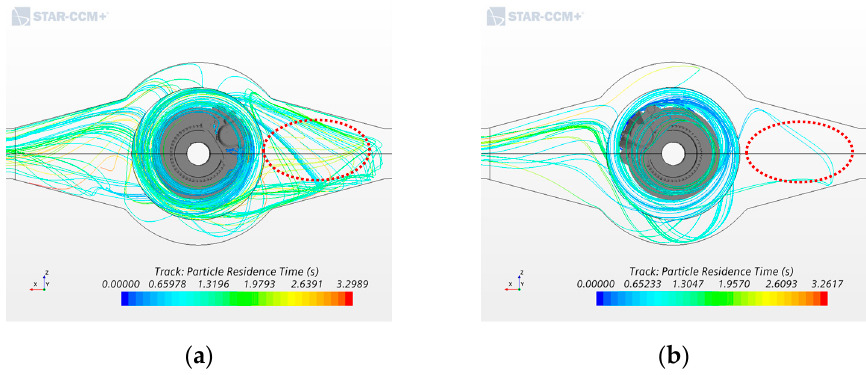
Figure 12. Particle residence time for the caliper angles: ( a ) α = 15°; ( b ) α = 23°.